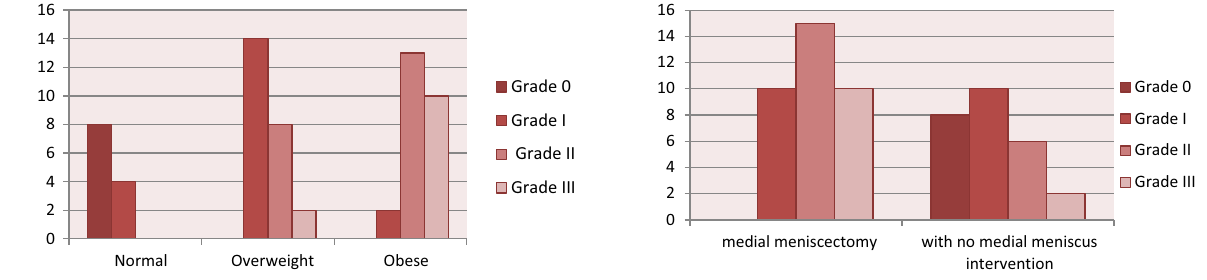
Fig. 3 Diagrammatic demonstration of the degree of cartilage degeneration and patients’ body weights